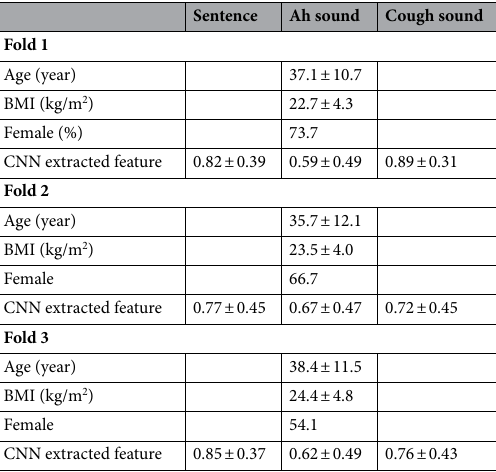
Table 4. Clinical characteristics and features extracted from CNN of each fold.